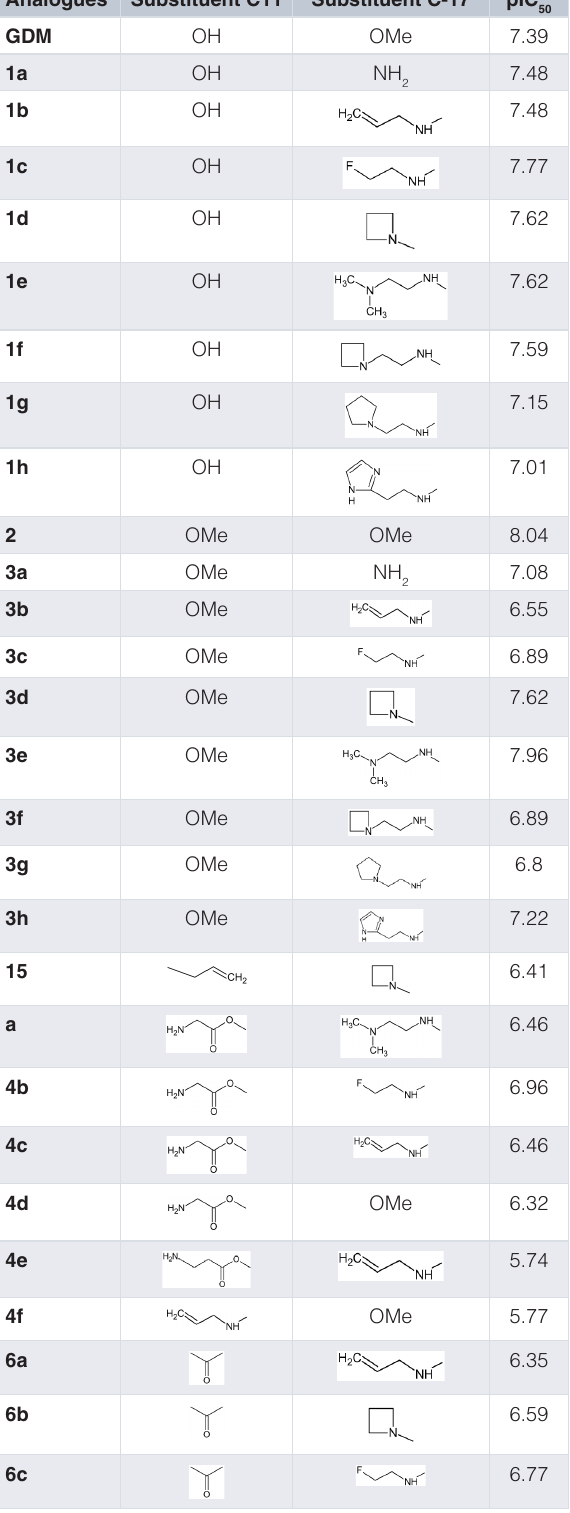
Table 1. Substituents of C-11 and C-17s positions of geldanamycin analogues. Analogues Substituent